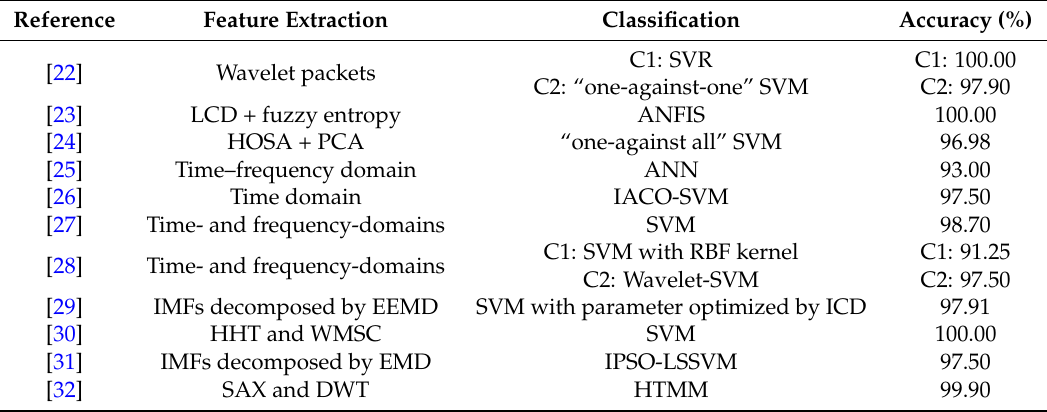
Table 6. Comparison between a number of other techniques. Support vector regressive (SVR), local characteristic-scale decomposition (LCD), support vector machine (SVM), adaptive neuro-fuzzy inference systems (ANFIS), higher order statistics analysis (HOSA), principal components analysis (PCA), artificial neural networks (ANN), improved ant colony optimization (IACO), radial basis function (RBF), intrinsic mode functions (IMFs), ensemble empirical mode decomposition (EEMD), inter-cluster distance (ICD), Hilbert-Huang transform (HHT), window marginal spectrum clustering (WMSC), improved particles warm optimization (IPSO), least squares support vector machine (LSSVM), symbolic aggregate approximation (SAX), discrete wavelet transform (DWT), hierarchical transition matrix model